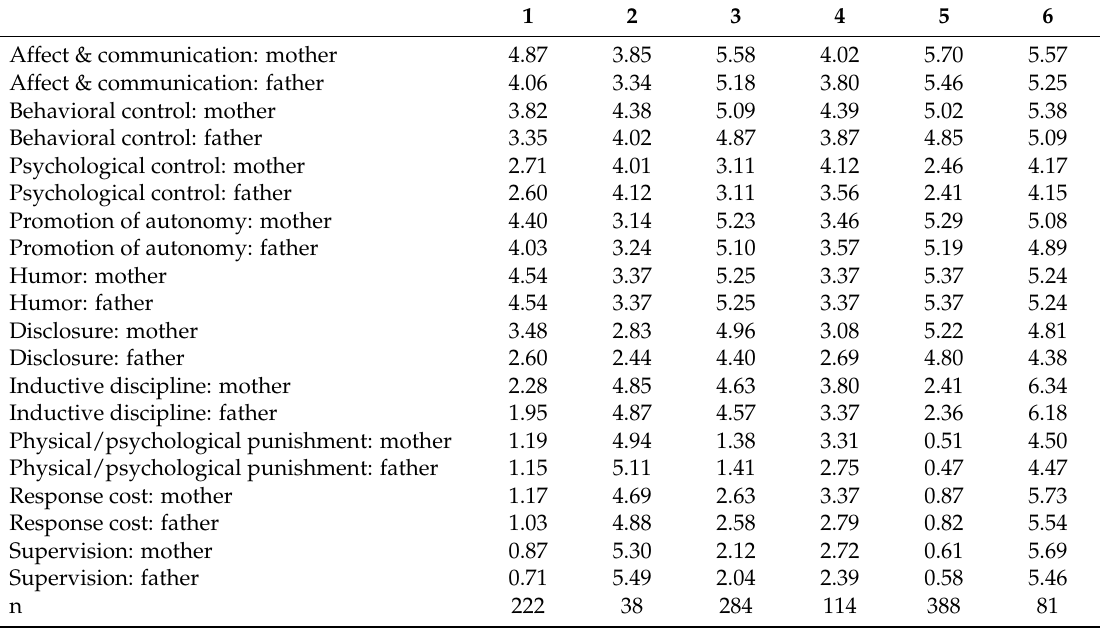
Table 1. Final areas of conglomerates of groups defined according to the scores on parenting